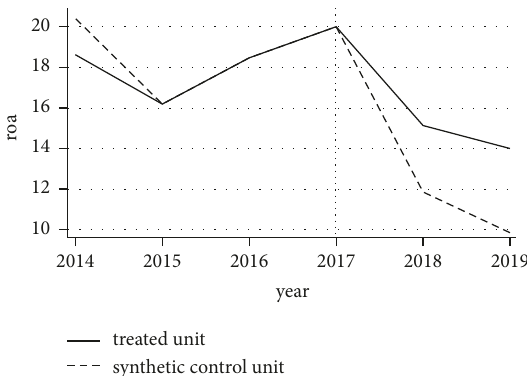
Figure 2: ROA figure of Yiming pharma. Note: Yiming pharma was successfully listed in Tibet through this policy in 2016. The trend of treatment group and control groups was basically the same before the occurrence of the policy in 2016. After 2016, both treatment group and control group showed a significant downward trend, but the decline of treatment group was more drastic and the gap between them was getting bigger (the figure is directly exported by Stata software).